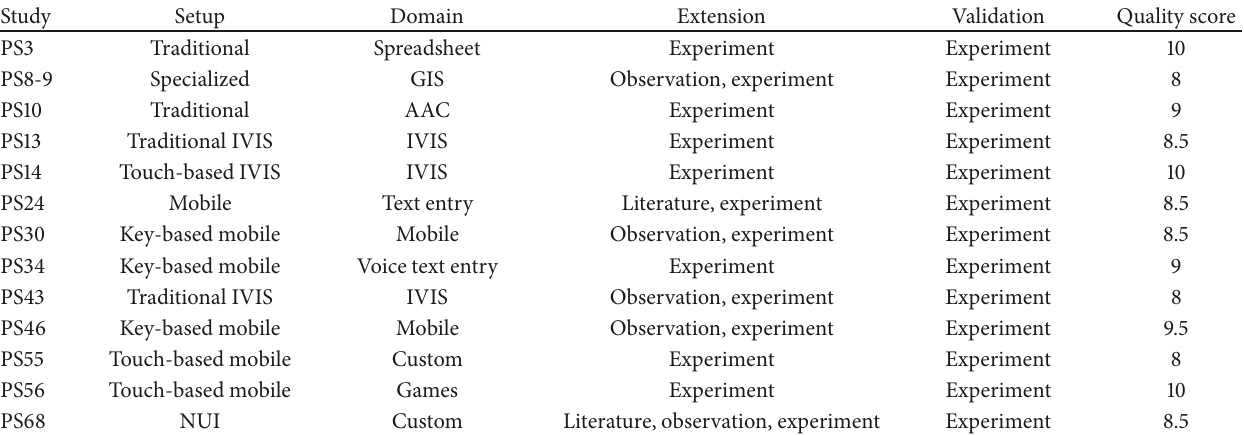
Table 12: Summary of high-quality studies based on this review that can guide designers and developers to the most appropriate KLM extensions.